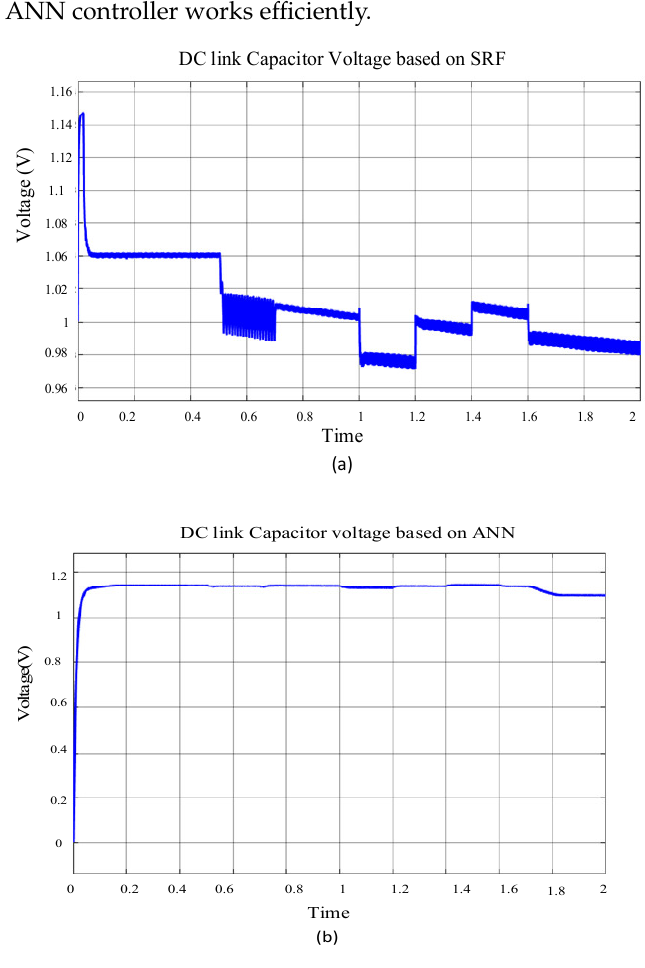
Figure 21. ( a ) SRF based DC link capacitor voltage, ( b ) ANN based DC link Capacitor voltage.